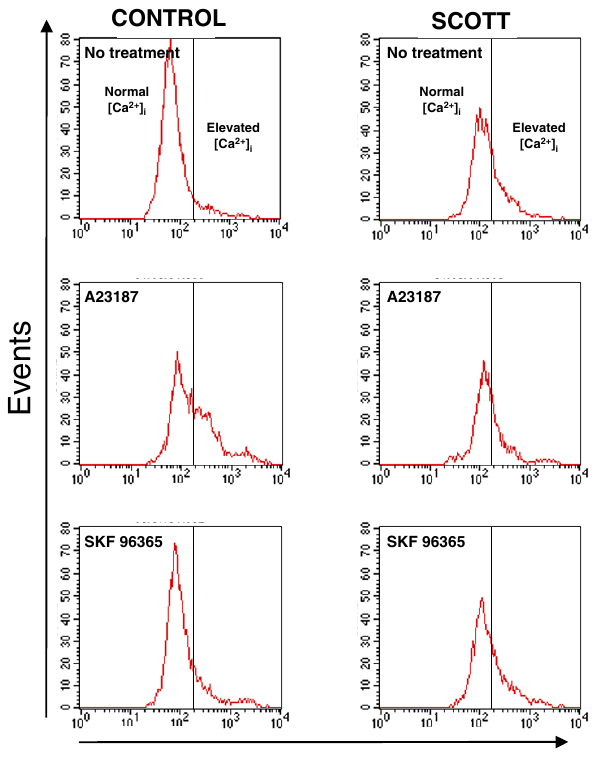
Figure 4 [Ca 2+ ] i determination in control and Scott cells by flow cytometry. Cells treated for 72 h by 200 nM A23187 or 10 µ M SKF 96365 were loaded with the fluorochrome Fluo-3 (3 µ M) and propidium iodide (PI, 10 µ g/ml). Histograms show the number of cells as a function of Fluo-3 fluorescence for the PI negative cell population only. One representative experiment out of four performed likewise is shown.